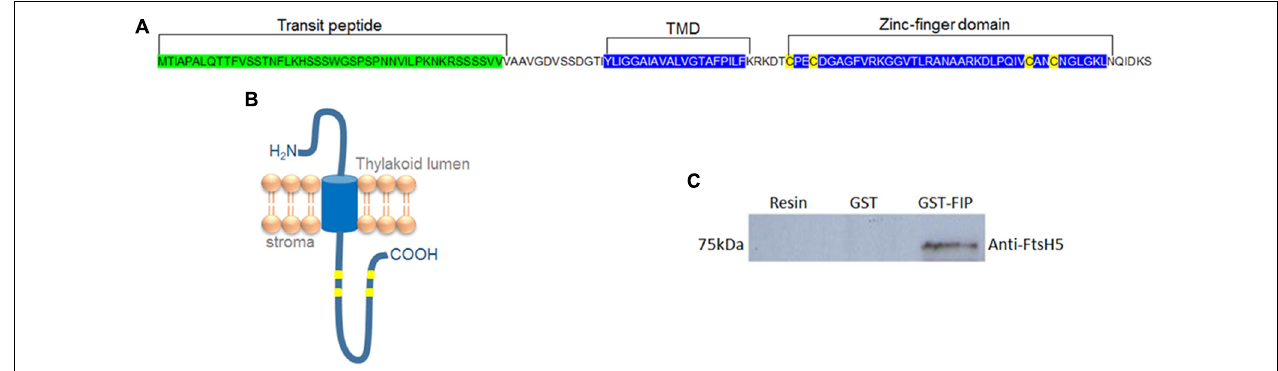
FIGURE 1 | FIP is a transmembrane protein containing a zinc-finger domain and is localized in the thylakoid membrane. (A) Amino acid sequence of FIP protein. The transit peptide, transmembrane domain (TMD), and zinc-finger domain are marked. (B) Theoretical model for FIP topology predicted by PROTTER online software. FIP is anchored in thylakoids by TMD and has an amino proximal luminal domain and a carboxyl proximal stromal domain. (C) glutathione S-transferase (GST) pull-down assay of the FtsH5 and FIP interaction. GST and GST-FIP fusion proteins were expressed in Escherichia coli and purified with a GST column. GST and GST-FIP were incubated with nickel resin-purified recombinant FtsH5 fusion protein, pulled down with GST-beads, and detected using an anti-FtsH5 antibody by Western blot analysis.